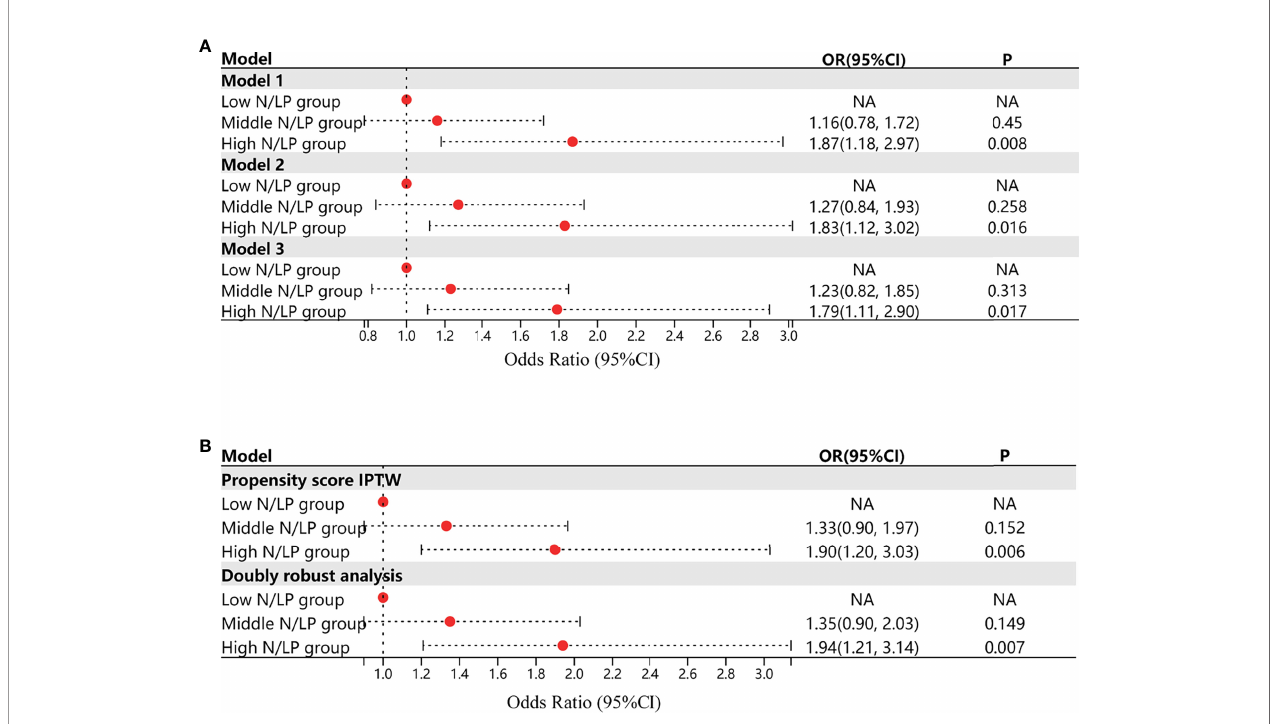
FIGURE 4 | (A) The results of univariate and multivariate logistic regression when analysed the in fl uence of varying N/LP levels on the occurrence of severe AKI in septic patients; Model 1 represented the univariate analysis; Model 2 represented the multivariate analysis adjusting all covariates; Model 3 represented the multivariate analysis adjusting gender, serum bicarbonate, serum chloride, serum creatinine, serum sodium, SOFA scores excluding coagulation system, Charlson comorbidity index based on the results of stepwise backward approach and collinearity analysis; (B) the results of univariate logistic analysis after inverse probability treatment weighting and the double robust estimation. Acute kidney injury was diagnosed based on serum creatinine and urine output criteria.